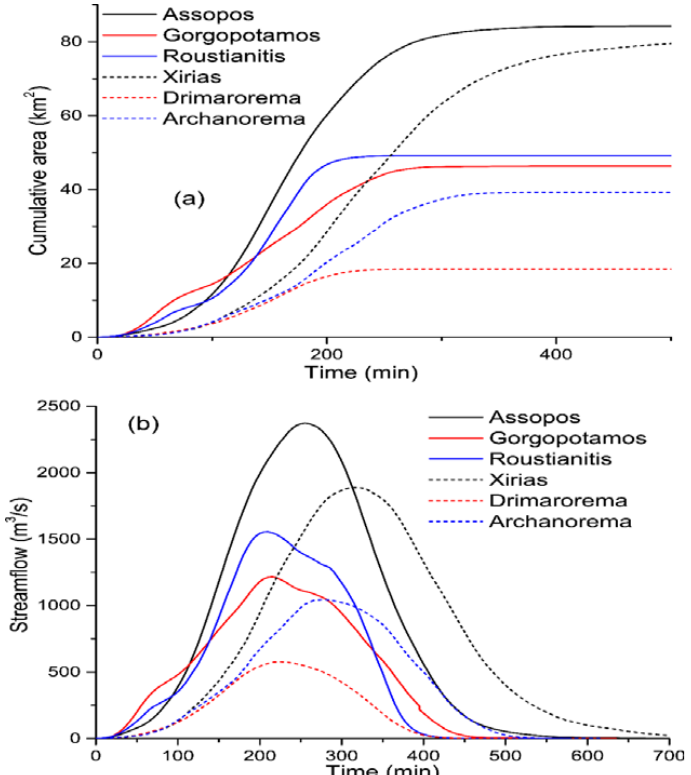
Figure 10. Graphs of ( a ) the time area curves of the investigated catchments and ( b ) the 3 h spatial distributed unit hydrographs, for the examined catchments. The first three catchments (solid lines) belong to the Southern part of Sperchios catchment and the other three (dashed lines) to the Northern part. Table 3. The calculated values of Giandotti formula for the comparable pairs of the southern and northern